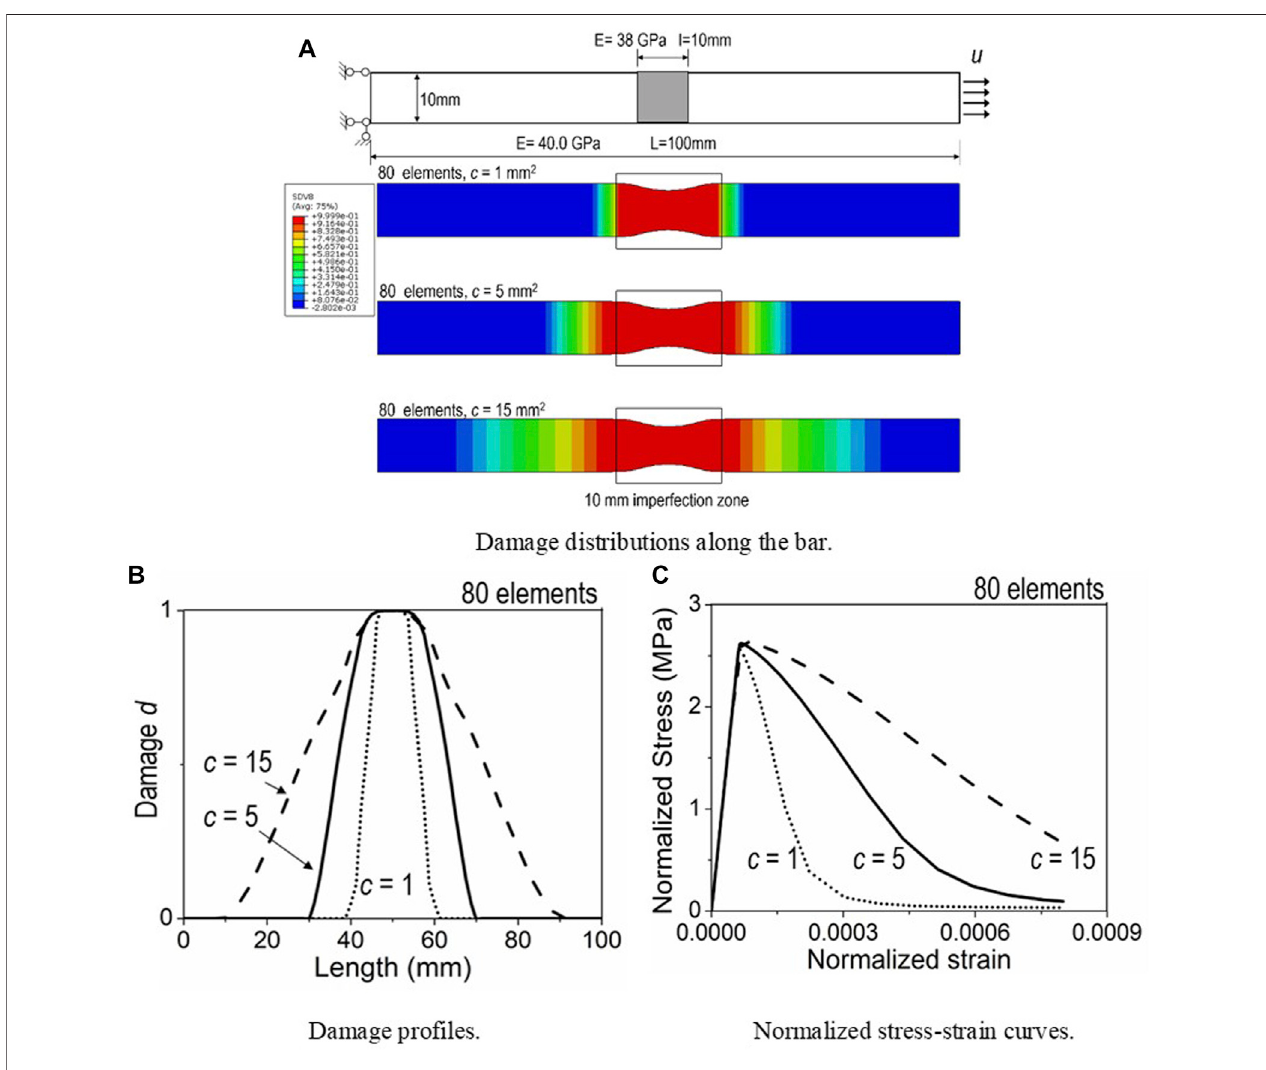
FIGURE 4 | Damage and normalized stress-strain curves for the simulations of different c